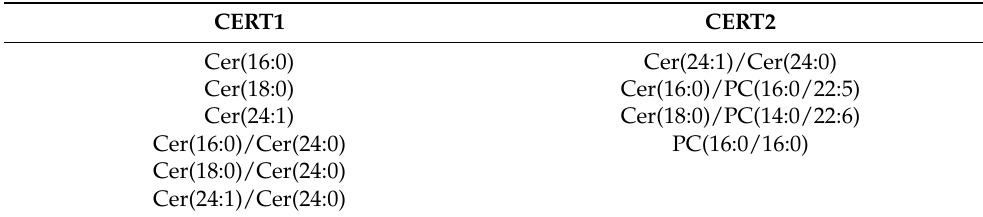
Table 1. Components of CERT1 and CERT2 risk scores (adapted after [60]). CERT1